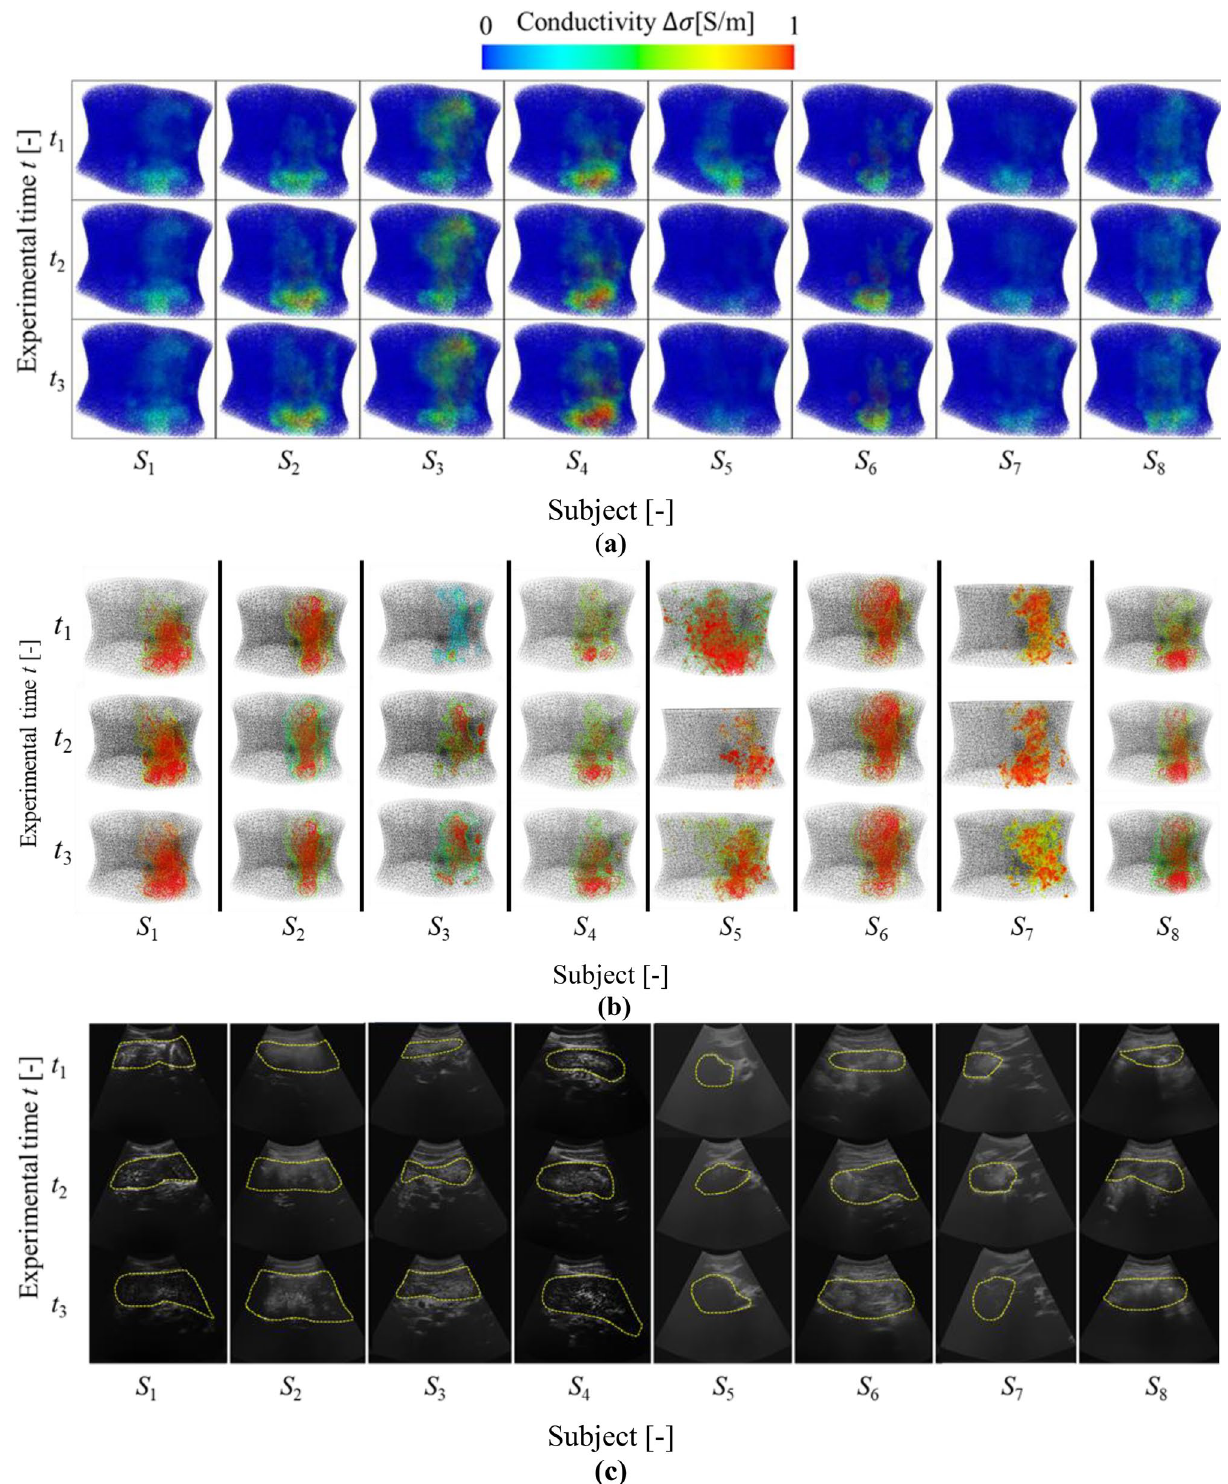
Figure 8. ( a ) Visualization of gastric conductivity distribution σ by g EIT Suit, ( b ) Extraction of clustered gastric conductivity distribution k σ by fuzzy clustering, ( c ) Evaluation of gastric area by